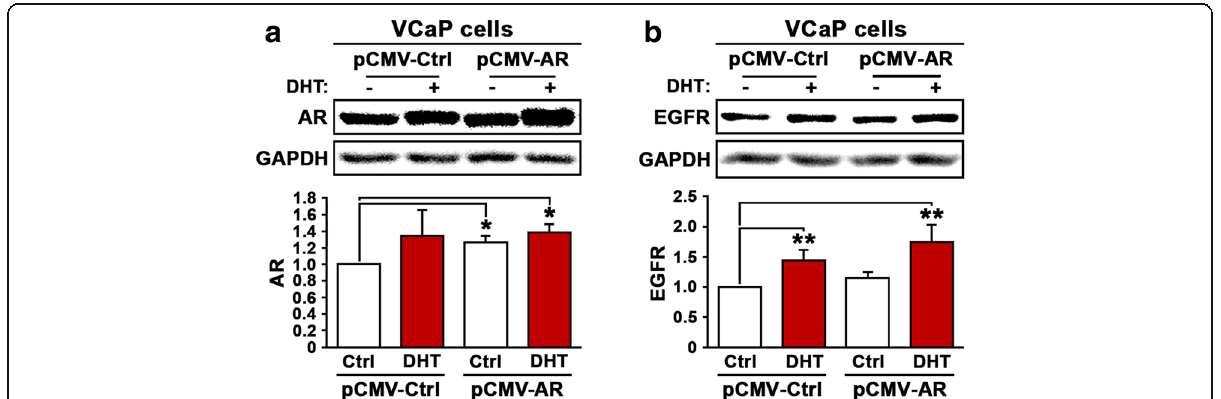
Fig. 2 Evaluation the effect of overexpression of AR and DHT treatment on expression of EGFR in VCaP cells. a Immunoblot analysis was performed to examine the expression of AR in VCaP cells that were transfected with pCMV control vector (pCMV-Ctrl) or pCMV-AR vector (pCMVAR) and followed by treatment with DHT or vehicle control. b Expression of EGFR protein in VCaP cells that were transfected with pCMV control vector (pCMV-Ctrl) or pCMV-AR vector (pCMVAR) and followed by treatment with DHT or vehicle control. Antibody against GAPDH was used as loading control. Data presented is average of three independent experiments (±SD). p <0.05 is indicated by “ * ” , p ≤ 0.01 is indicated by “ **